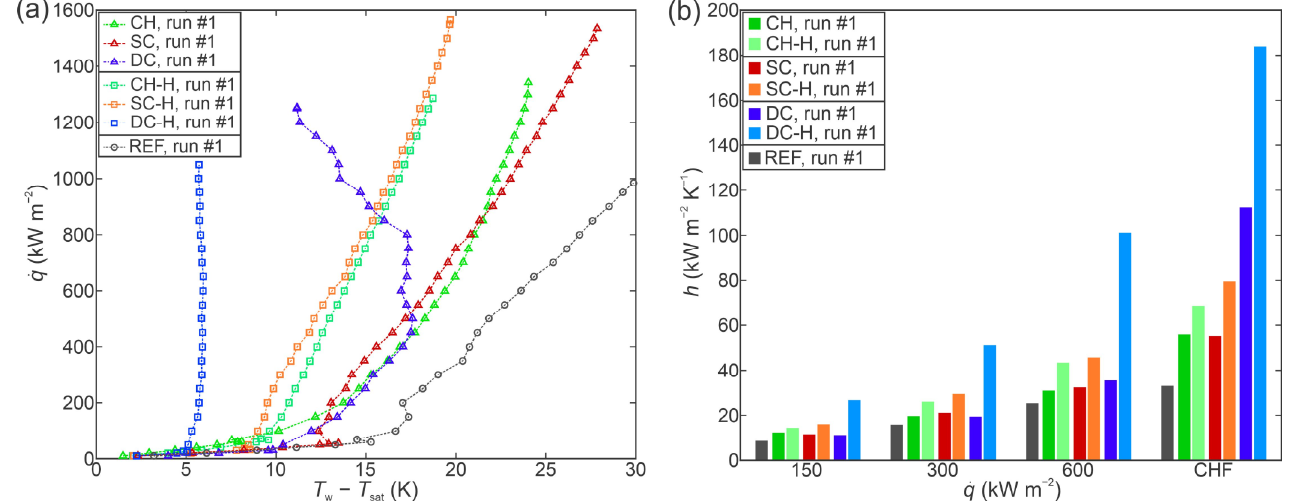
Figure 7. Comparison of boiling performance of all samples during the first experimental run through ( a ) boiling curves and ( b ) heat transfer coefficients at selected heat fluxes.